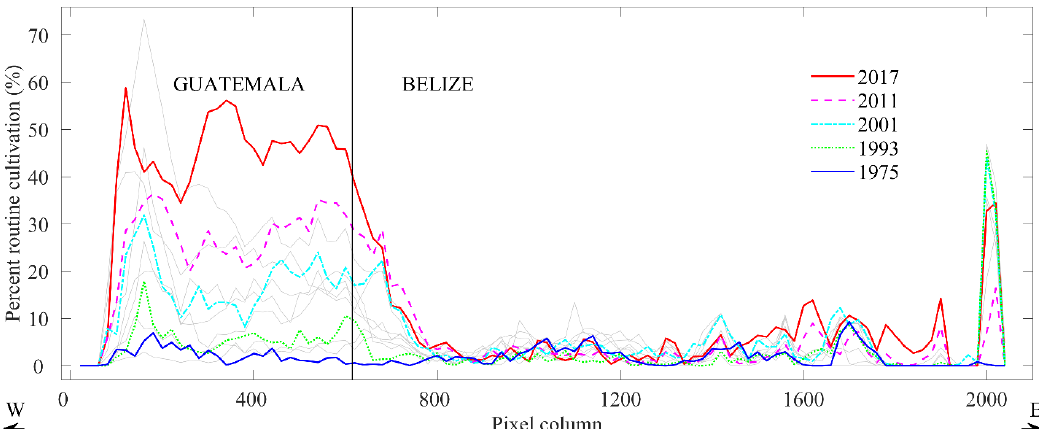
Figure 4. Percentage of land under routine cultivation in the Moho River watershed for all the 12 years shown in Table S1. Years 1975, 1993, 2001, 2011, 2017 are highlighted with colors and line types. Light gray lines show results for the other seven years.